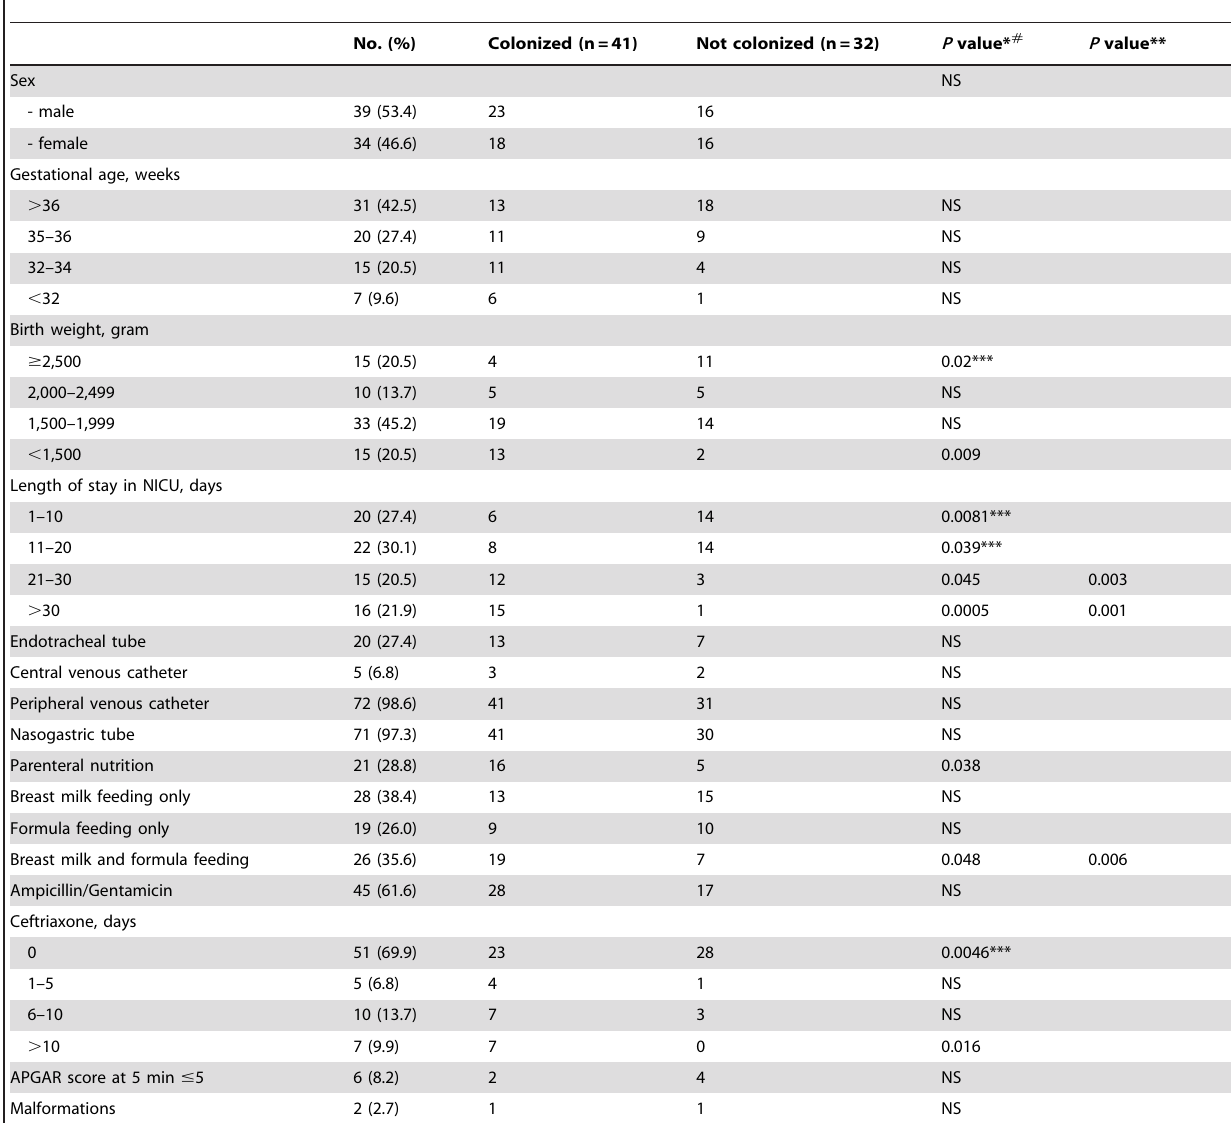
Table 1. Characteristics of the neonates and risk factors for colonization with ESBL-producing Gram negative bacteria during NICU